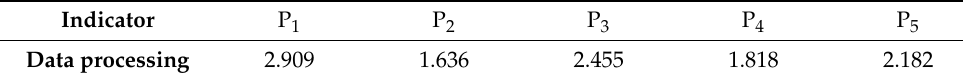
Table A11. Data processing of Personnel risk (P).